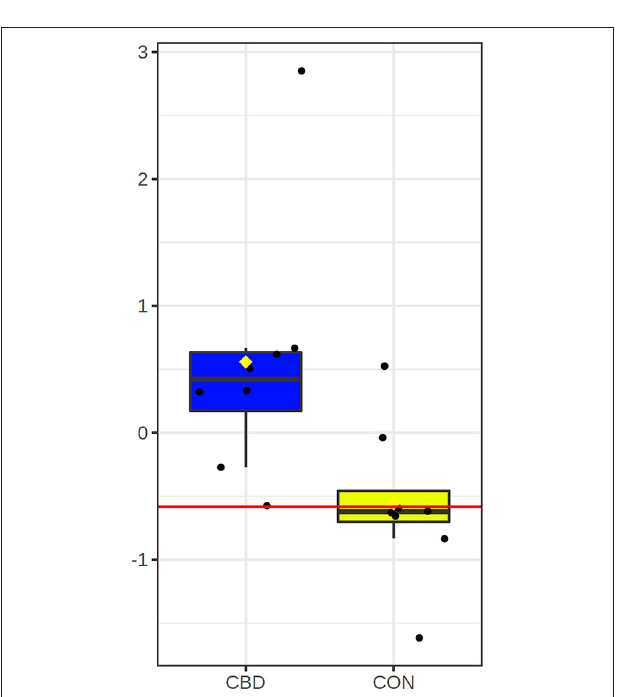
FIGURE 4 | Box and whisker plot for candidate carbonyl-containing biomarker altered by cannabidiol (CBD; in blue) compared to control (CON; in yellow). Glucose (AUROC = 0.91; P = 0.020) was the only candidate biomarker for carbonyl-containing